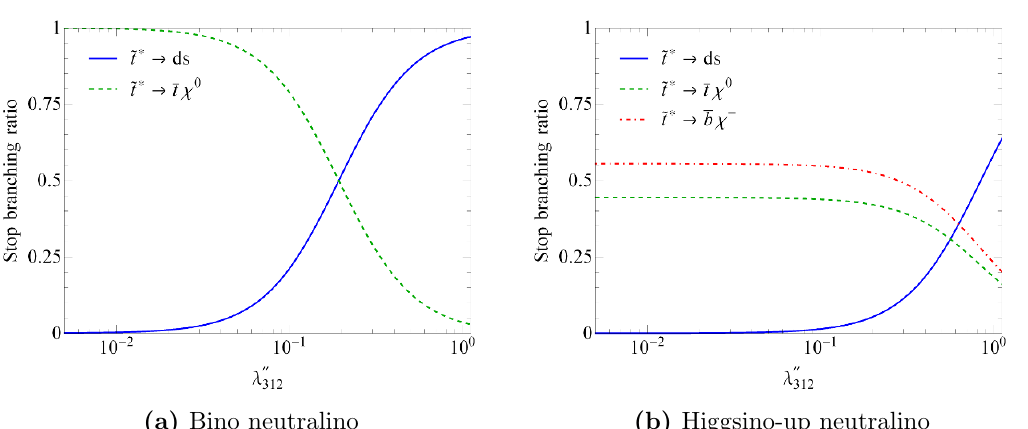
Figure 7. Branching ratios for a 600 GeV stop as a function of (cid:21) 00 mass has been set to 200